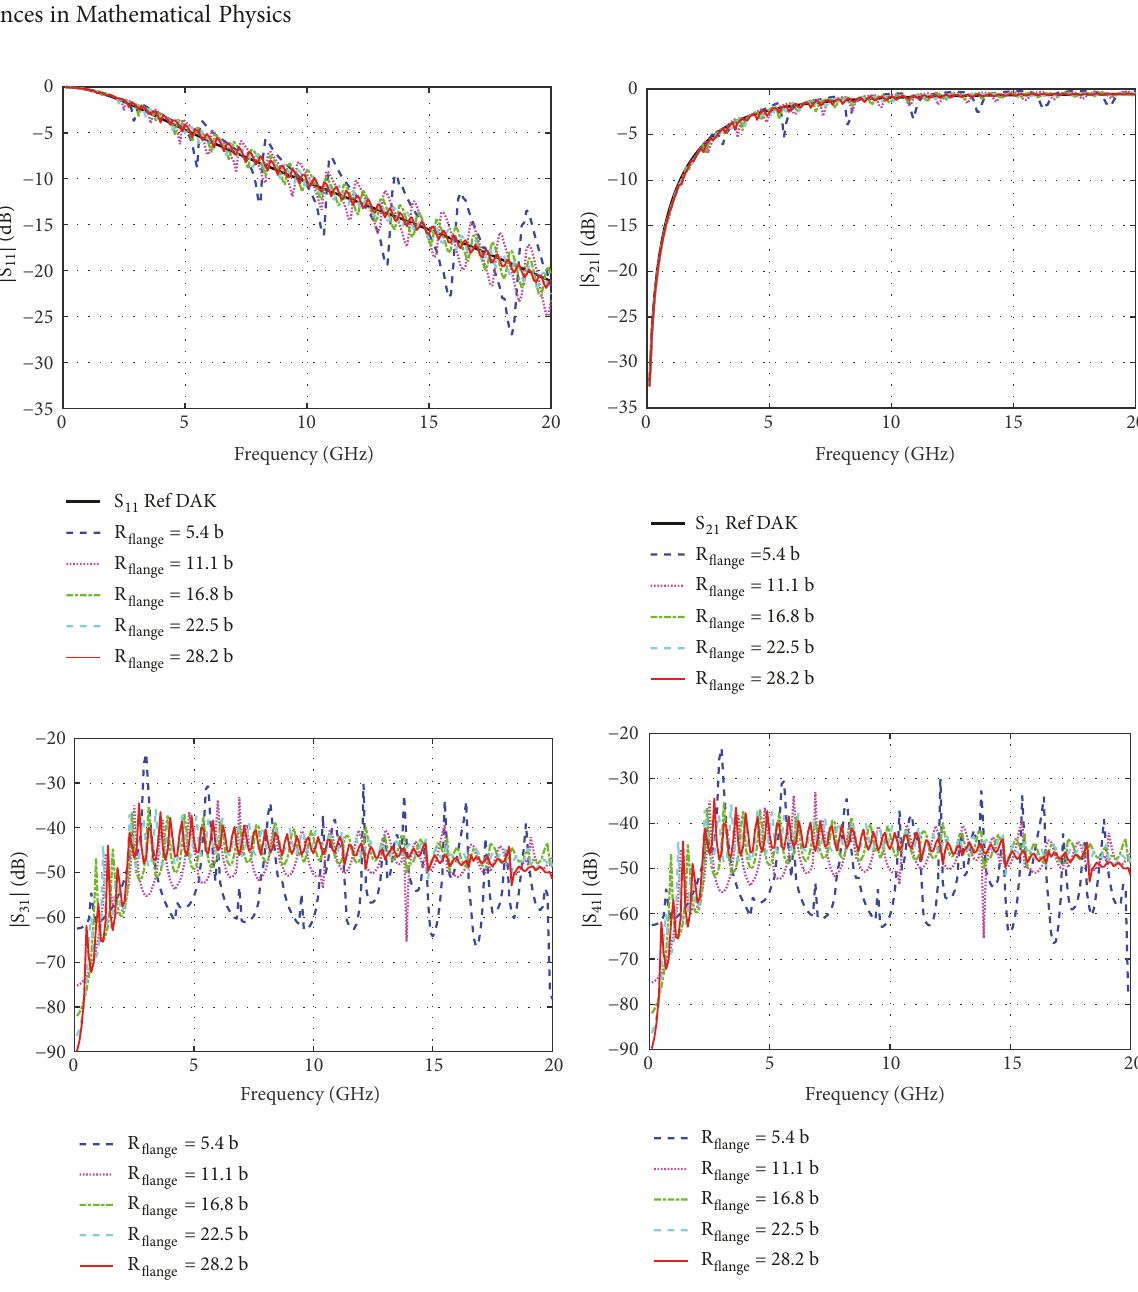
modes at the input/output coaxial lines, for different values of the n